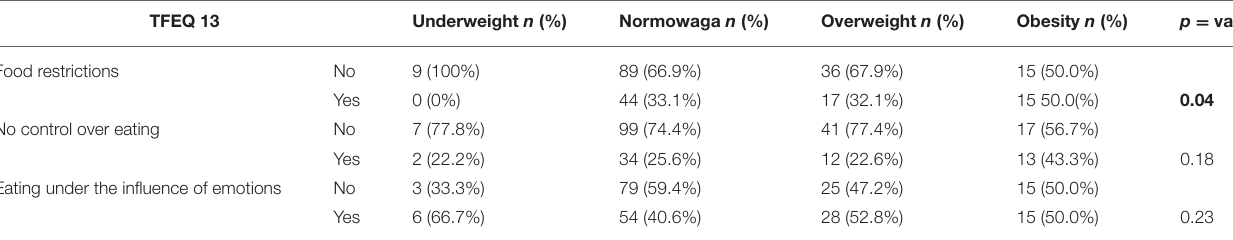
TABLE 5 | Ratings of the emotional aspect of weight-related eating behaviors ( n = 225). TFEQ 13 Underweight n (%) Normowaga n (%) Overweight n (%) Obesity n (%) p =